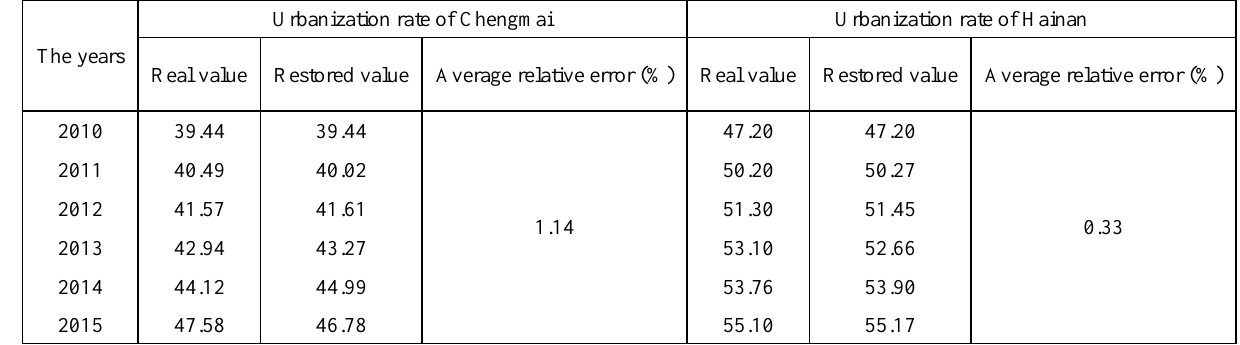
Table 1. Restored value and average relative error of urbanization rate (2010-2015)